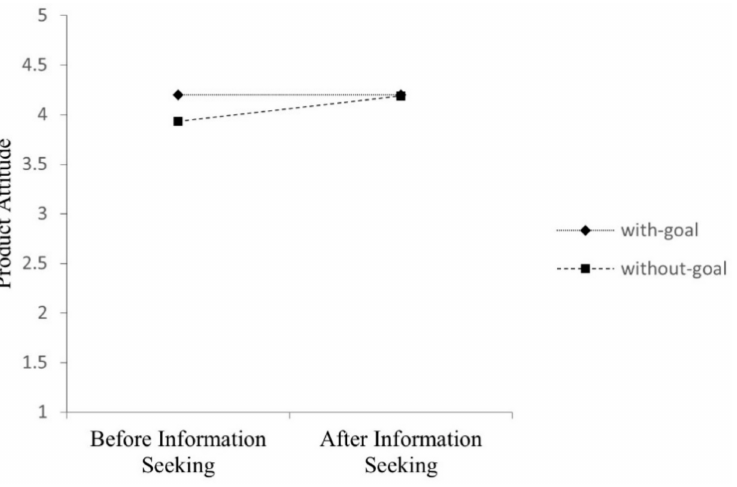
Figure 4. Purchase attitude as a function of information seeking and consumption